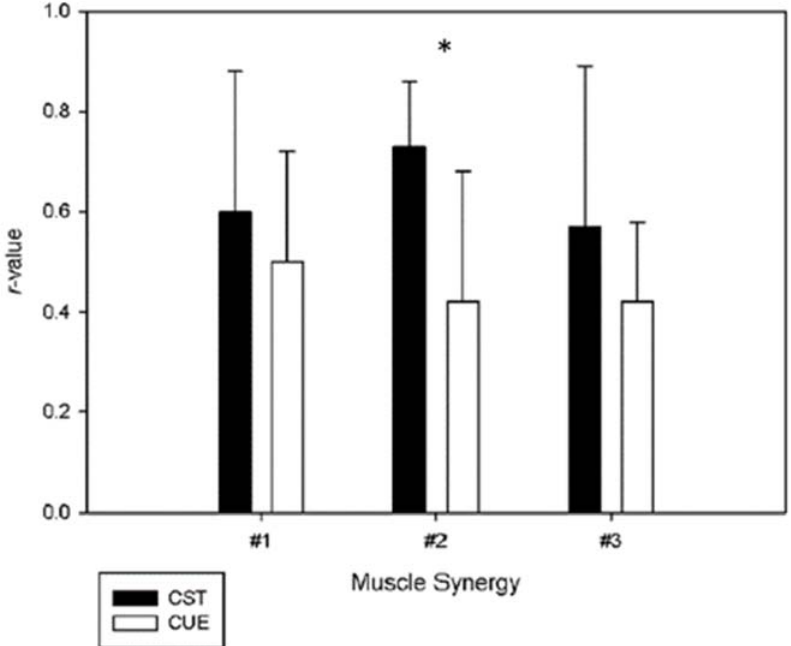
Figure 3. Muscle synergy vectors comparison between participants with (CST) and without (CUE) anterior background in general strength training. (*) represents significative differences between the two groups.